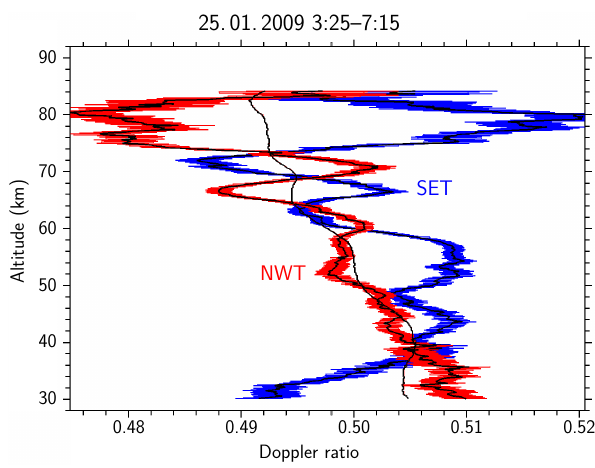
Fig. 5. Mean profiles of Doppler ratio for the NWT (red error bars) and the SET (blue error bars), both measuring zonal wind speed, but in opposite directions. The black line shows the calcu- lated Doppler ratio for zero wind speed with regard to measured atmospheric